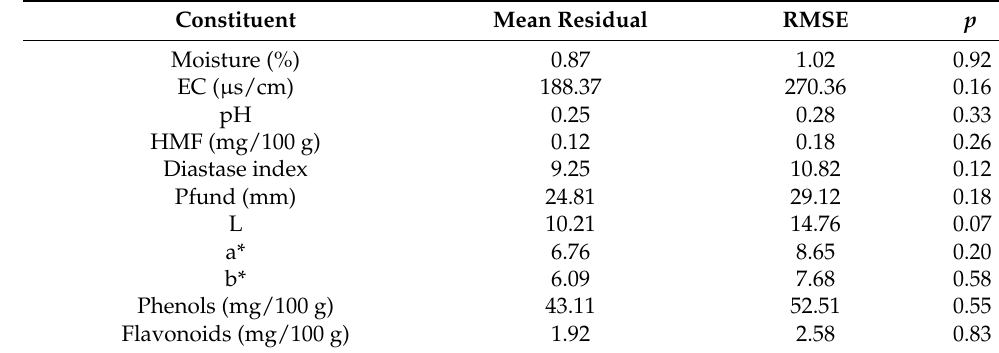
Table 3. External validation of physicochemical properties in honeys by NIR (16 samples).